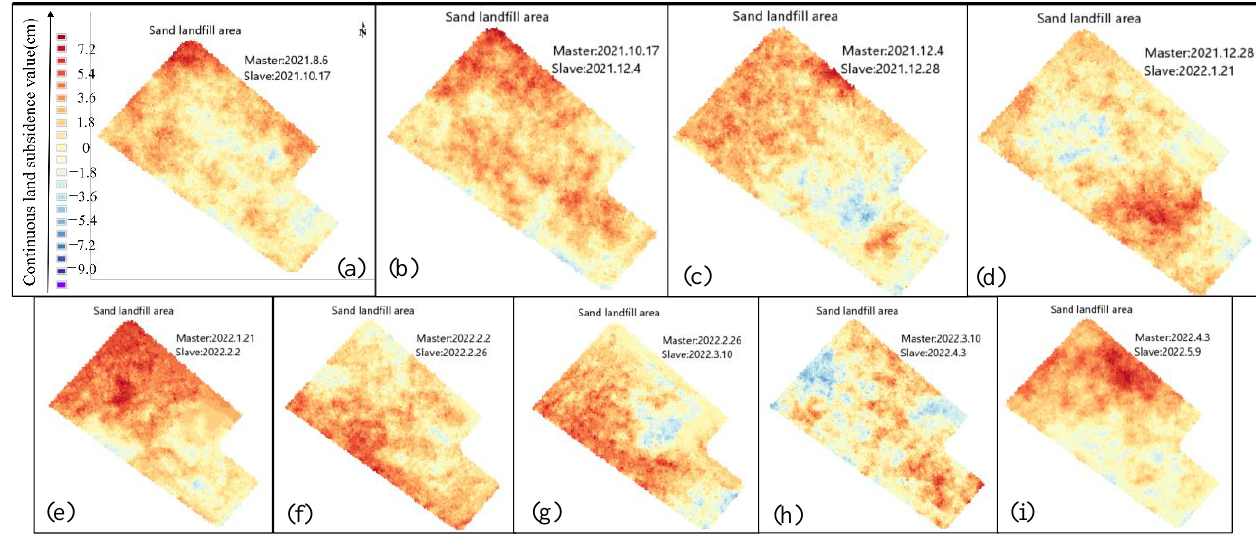
Figure 6. The amount of ground change (subsidence/cm) detected by D-InSAR continuously and periodically during the process of sea sand reclamation in the Mud receiving area. ( a – i ) plots correspond to different continuous time intervals.